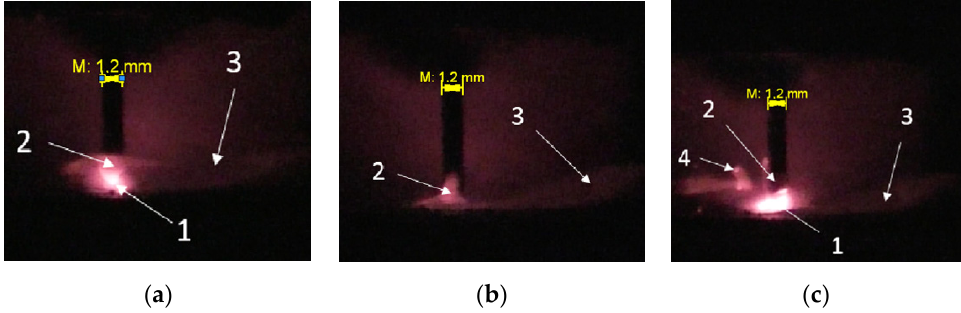
Figure 3. Material transfer result: ( a )—accumulation of the droplet, ( b )—shot circuit, ( c )—the material transfer re-ignition of the arc. 1—arc, 2—droplet, 3—molten pool, 4—spatter.